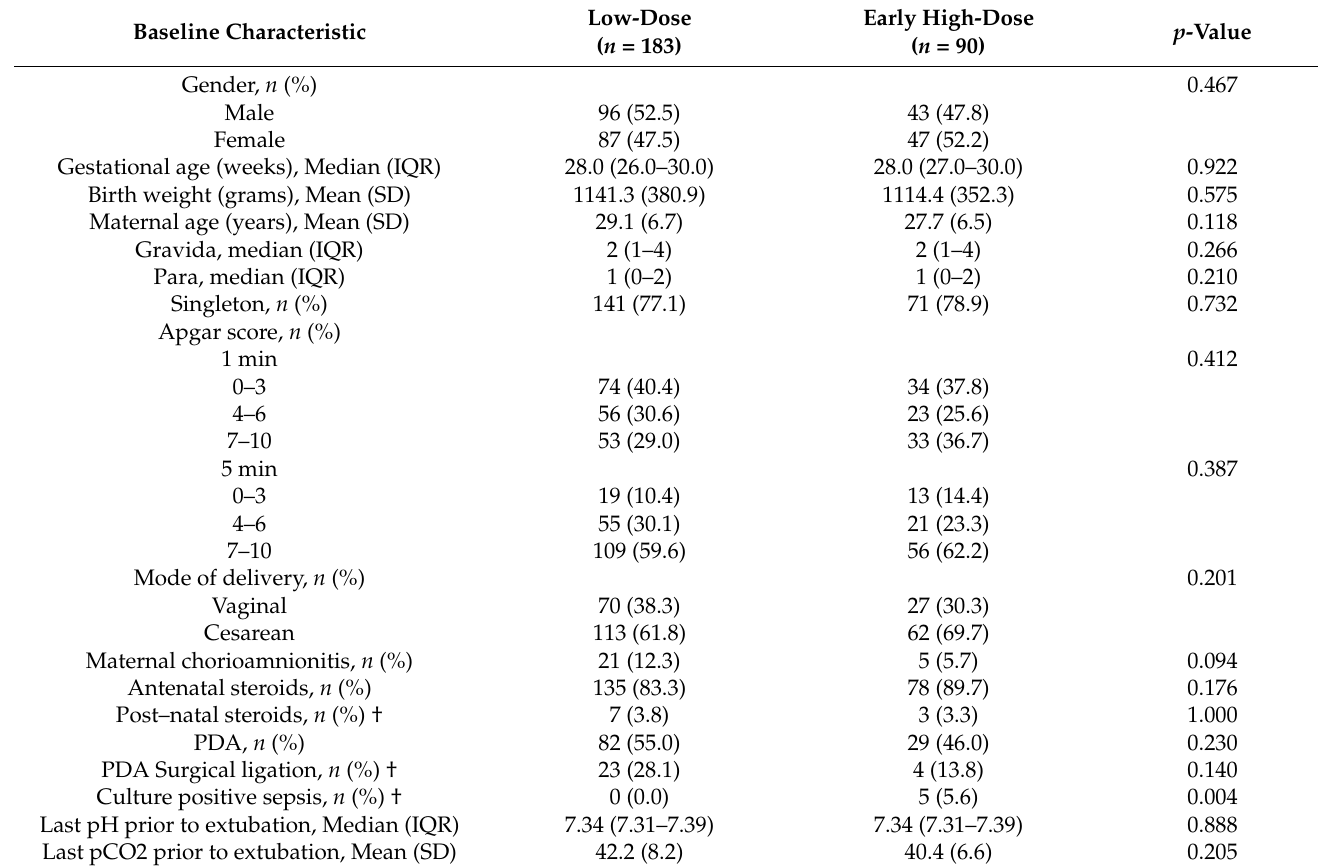
Table 1. Baseline characteristics of study groups.